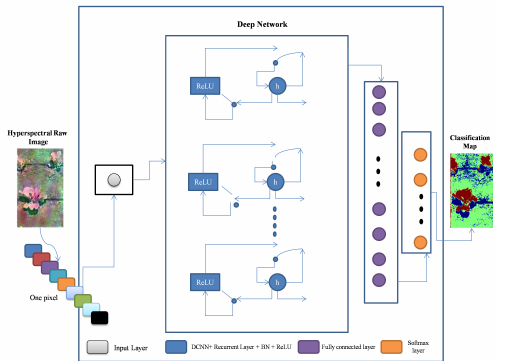
Figure 6: Deep learning with ResNet Recurrent neural network for hyperspectral image classification: Proposed deep network